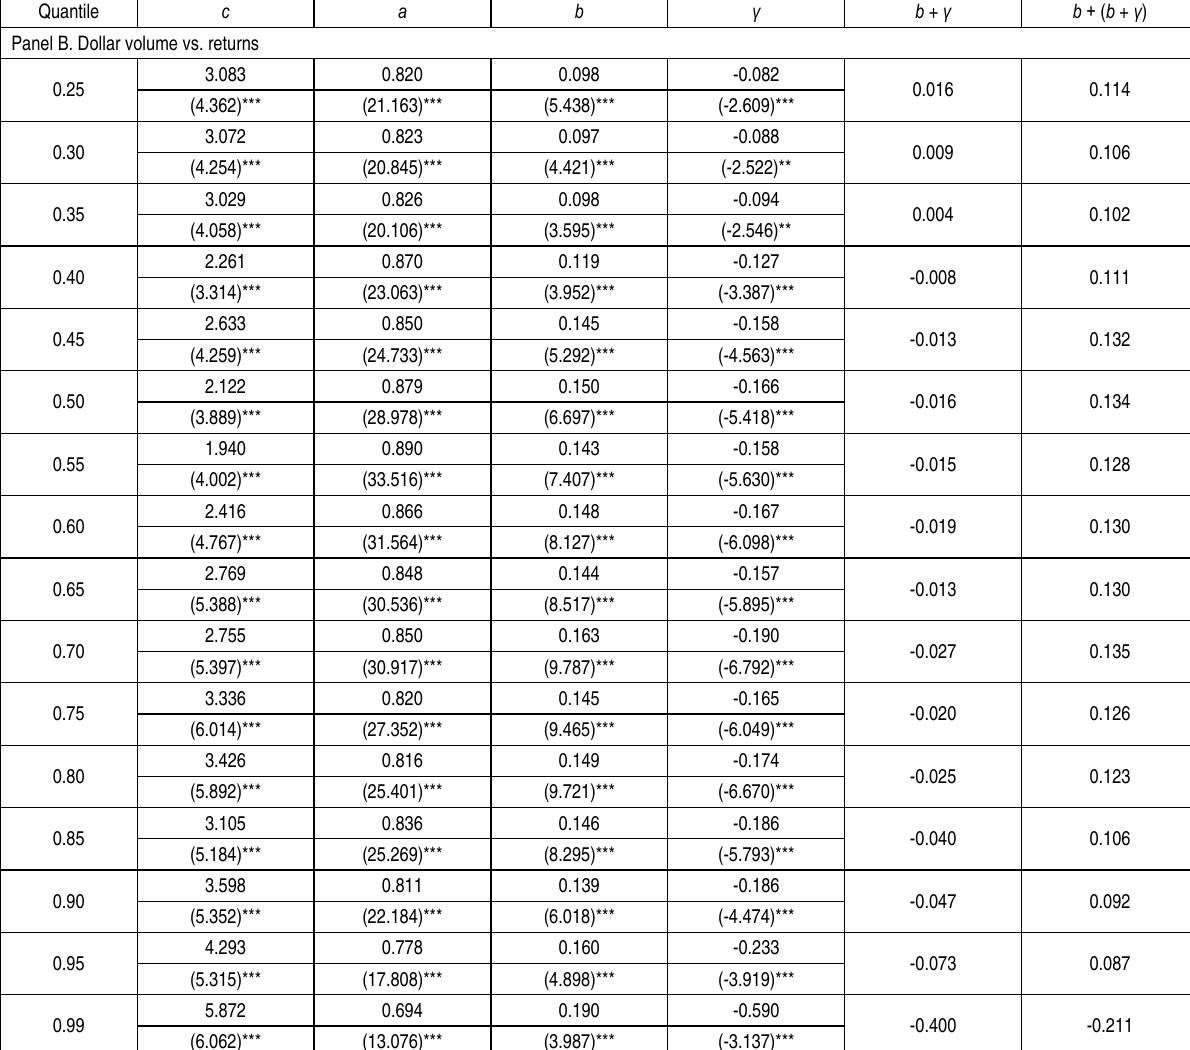
Table 6 (cont.). Quantile regression estimates of volume-signed return correlation for TAIEX in the pre-eliminated period